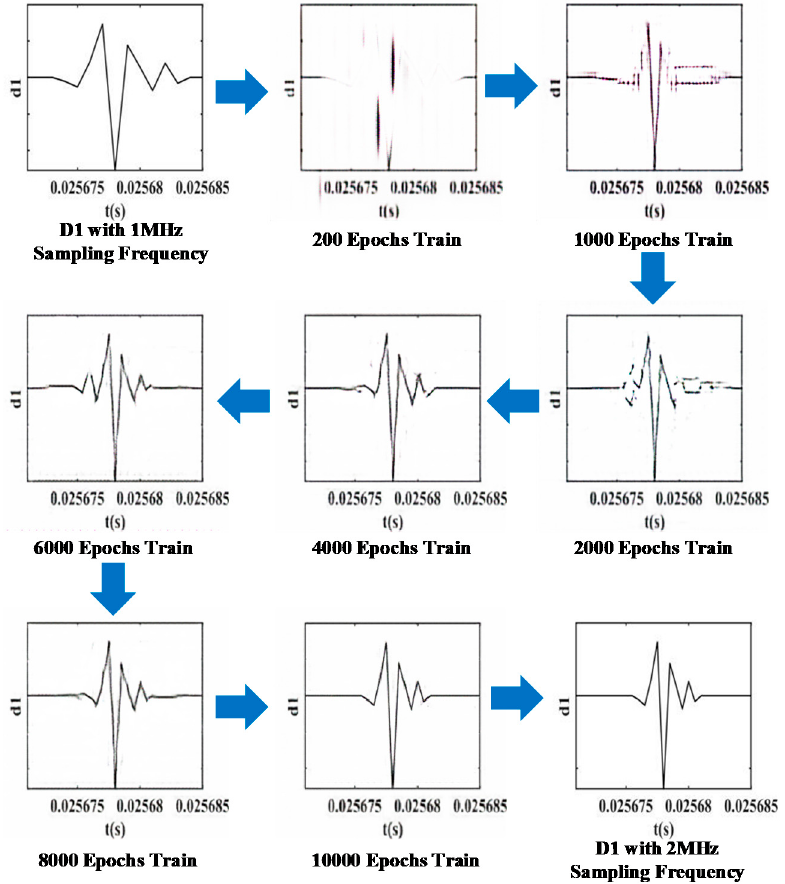
Figure 9. Pix2Pix training process.